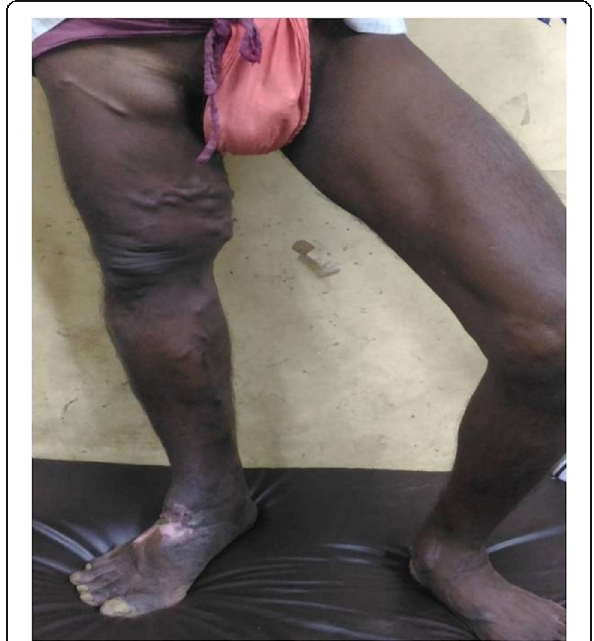
Fig. 1 Clinical photograph of first patient showing varices in right thigh and right leg with a healing venous ulcer in the dorsum of the right foot. There is shortening of the right lower limb as compared to the left lower